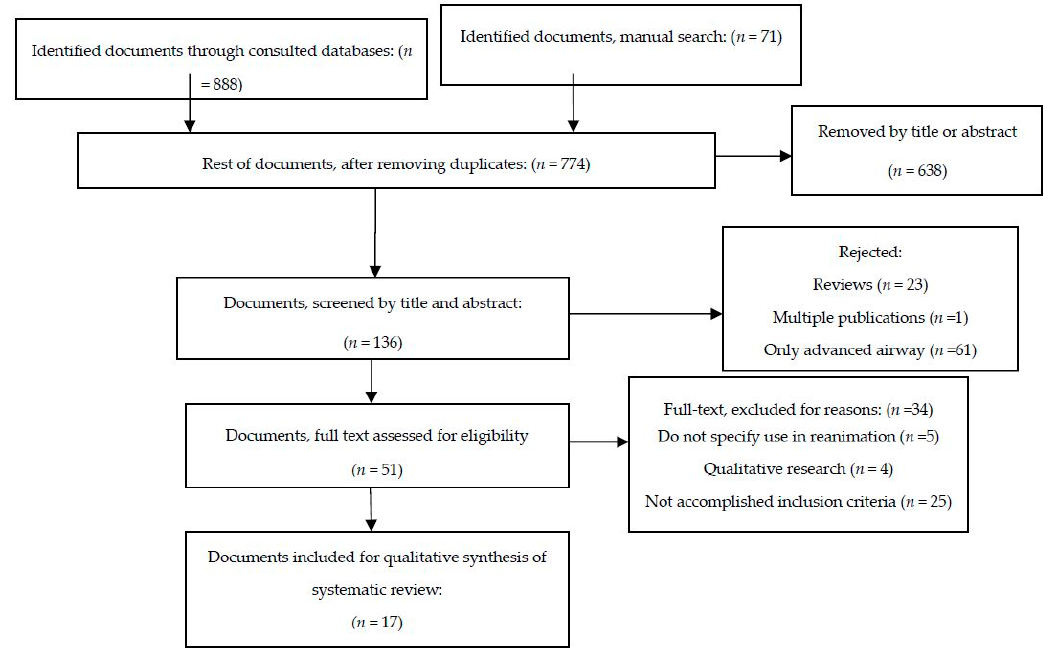
Figure 1. Flow-chart of information according to the review stages.